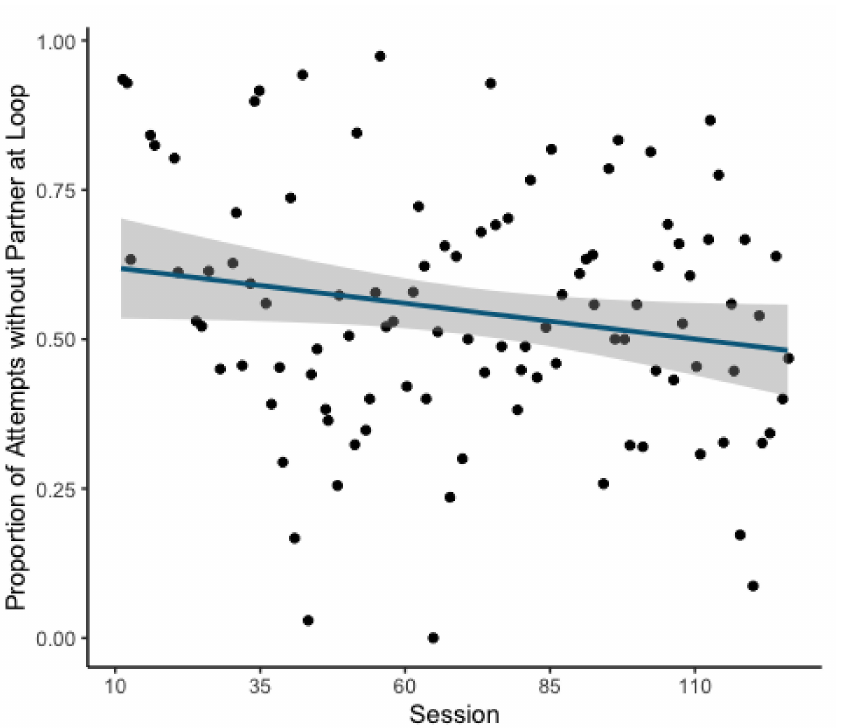
Figure 3. Scatterplot of overall proportion of attempts without a potential partner in front of the opposite loop. Line of best fit overlaid with surrounding greyed area indicating standard error.